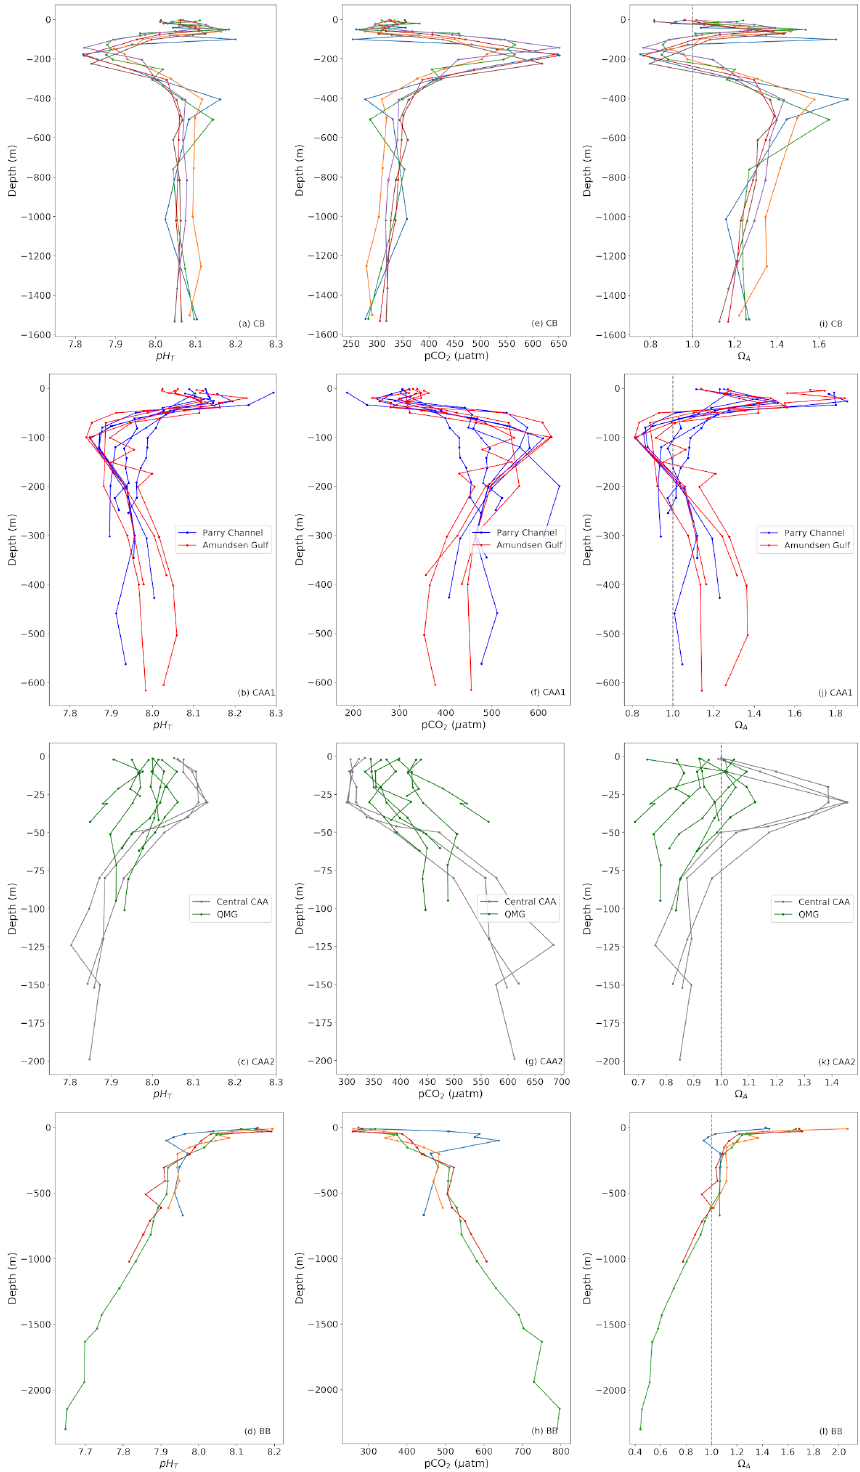
Figure 7. Depth profiles of pH T (left), p CO 2 (middle) and (cid:127) A (right) at representative stations of the Canada Basin (CB; top), Baffin Bay (BB; bottom) and the Canadian Arctic Archipelago (CAA). The latter is divided into four subregions (shown on Fig. 2): Parry Channel, Amundsen Gulf, Central Archipelago and Queen Maud Gulf